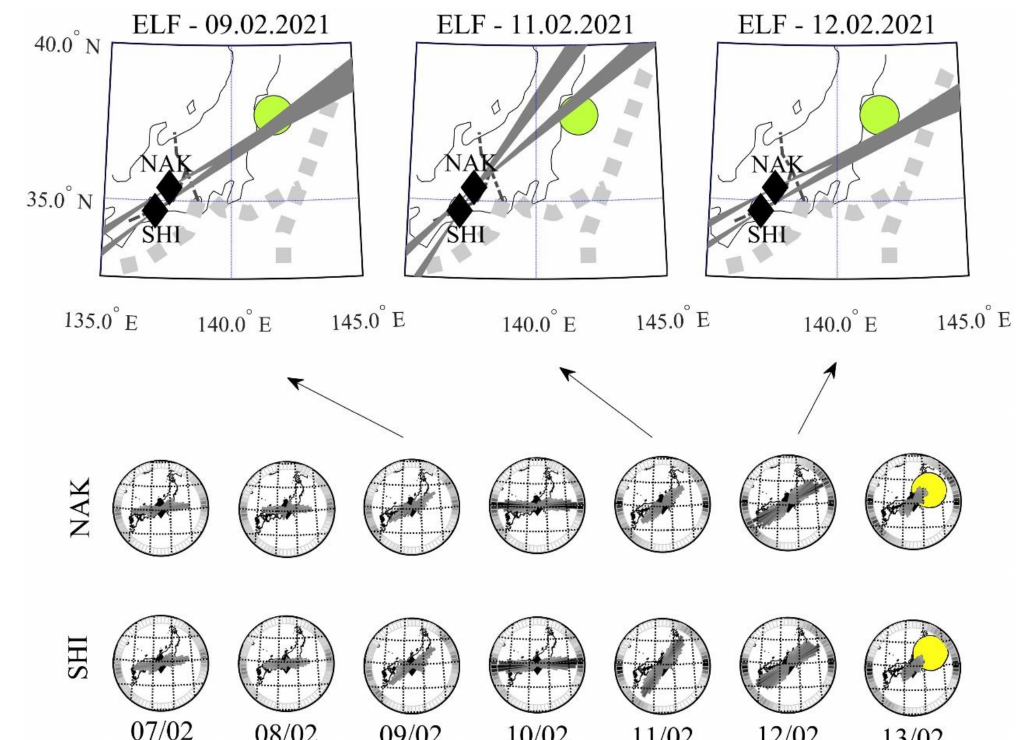
Figure 6. Evolutions of the azimuth distributions of ULF/ELF radiation for the first EQ on 7–12 February 2021 observed in Nakatsugawa (NAK) and Shinojima (SHI) are shown on two rows of round panels. The three upper panels illustrate the positions of the modes (main lobes) of the azimuthal distributions. The positions of the magnetometers are depicted by two rhombuses and the EQ by a circle.